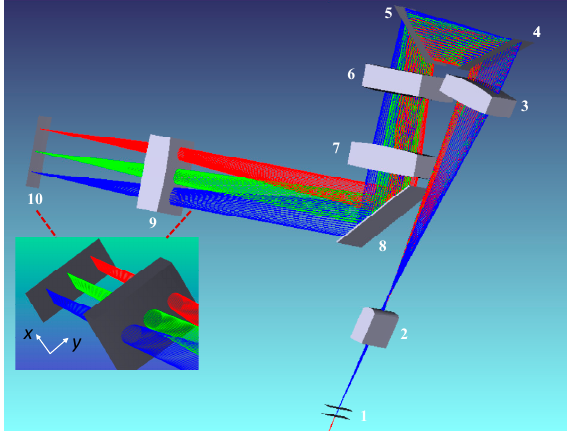
Figure 2. The proposed compact light path using dual-grating. The insets show the receiver beam distribution on the LCoS plane at a 45° view. The numbers 1–10 represent: No. 1 is the polarization converter with a birefringent crystal YVO 4 and half-wave plates; Nos. 2 and 3 are cylindrical mirrors with focal lengths of 4 mm and 60 mm, respectively; Nos. 4 and 5 are transmission gratings with 1000-line/mm resolution; Nos. 6, 7, and 9 are cylindrical lenses with focal length of 141 mm; No. 8 is a mirror; No. 10 is an LCoS chip, whose working wavelength is from 1520 nm to 1620 nm, pixel size is 8µm, fill factor is 87% and resolution is 1920 × 1080.